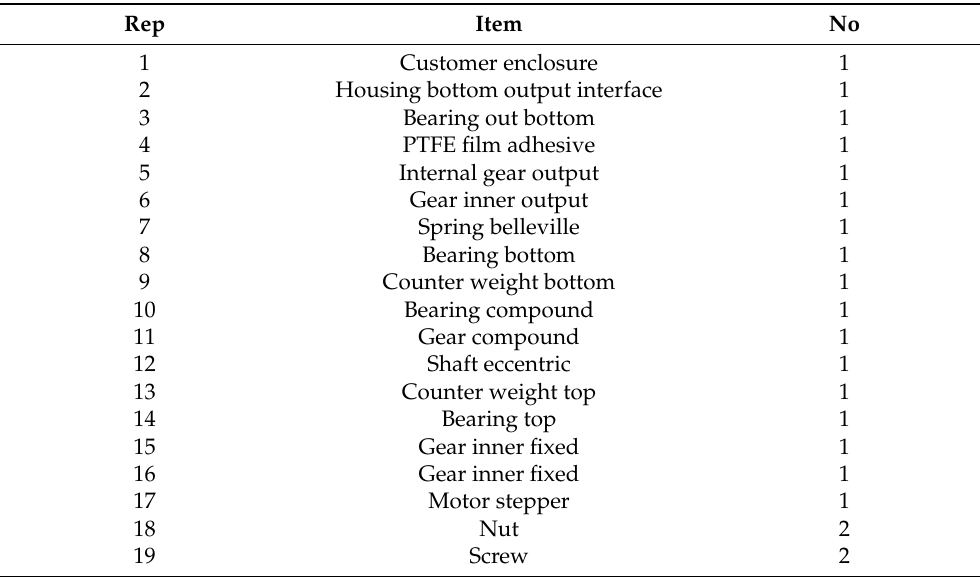
Figure 7. The exploded view of the speed reducer design. Table 2. Speed reducer assembly nomenclature.